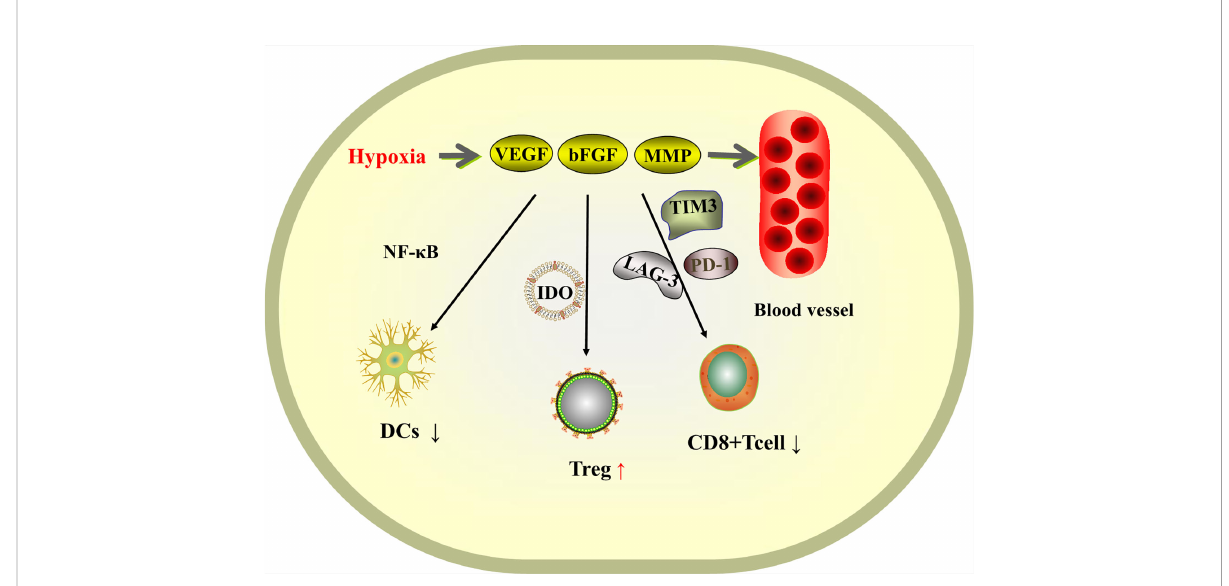
FIGURE 3 Schematic diagram of the mechanism of tissue hypoxia-induced VEGF-promoted tumor vascular proliferation and